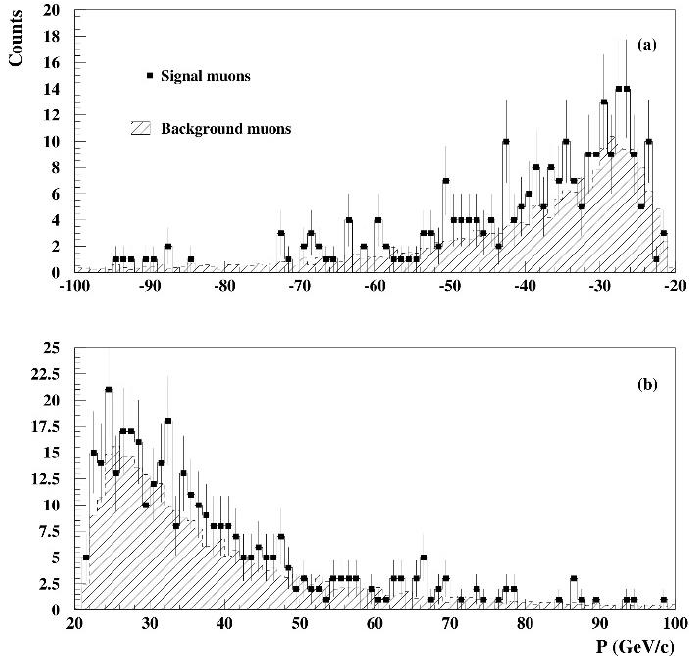
Figure 6. Momenta distribution of muons in the cell No. 48 and in the 8.39 min live-time bin at 00:07 UT on 9th November 2000. ( a ) Muon minus momenta and ( b ) muon plus momenta.